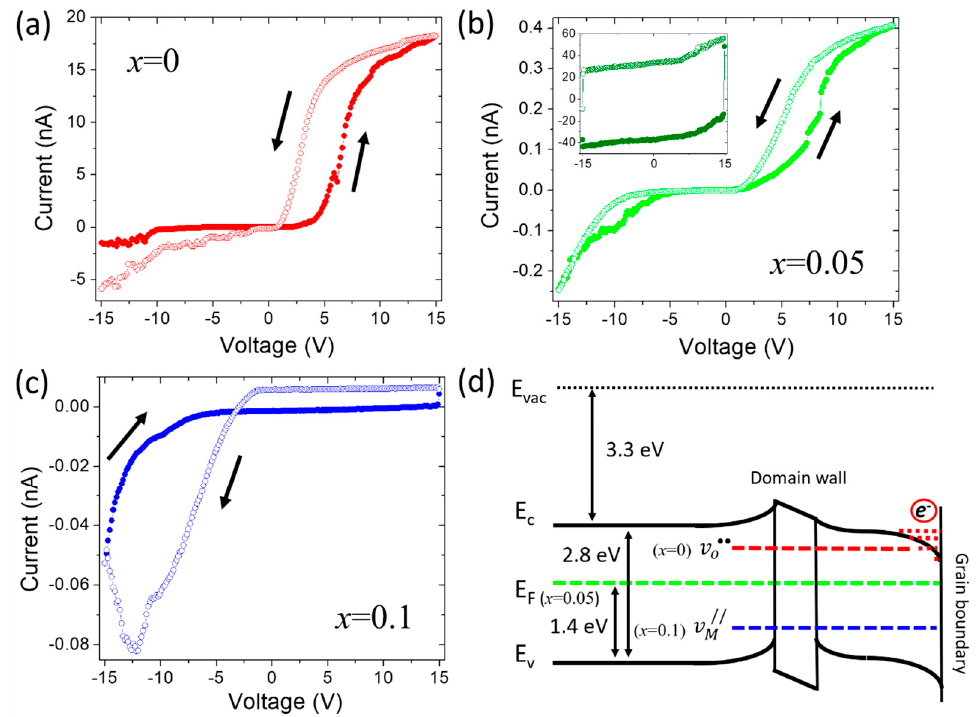
Figure 4. Local current-voltage dependencies for the Bi 0.95 Ca 0.05 Fe 1 − x Ti x O 3 − δ samples, as measured within conductive areas: ( a ) x = 0, ( b ) x = 0.05, ( c ) x = 0.1. The inset shows the dependence characteristic of insulating regions (the vertical scale is in pA). ( d ) The band diagram representation considering the influence of grain boundaries and domain walls on the energy band bending depending on the chemical composition. The values representing the Fermi level (1.4 eV), bandgap (2.8 eV), and the electron affinity (3.3 eV) of BFO were taken from Refs. [13,15,42].